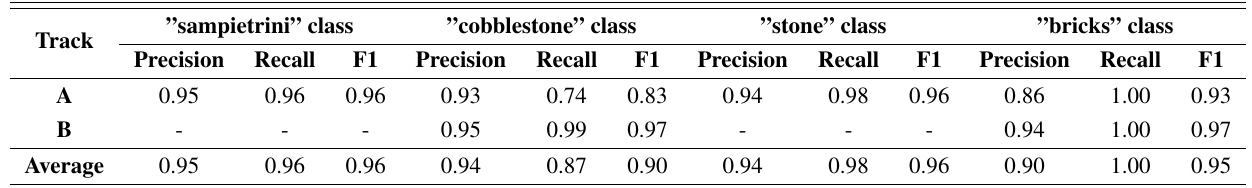
Table 3. Performance values of the paving material characterisation method, in terms of Precision, Recall and F1-score. Please note